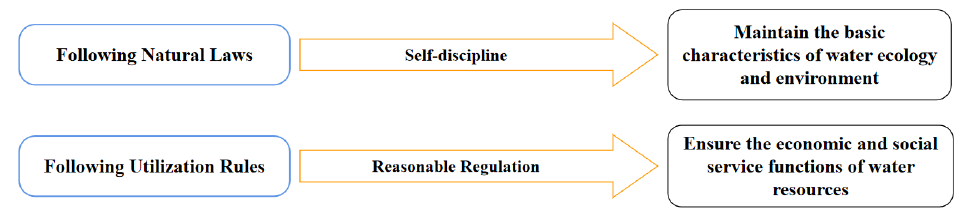
Figure 3. The regulation of the virtuous